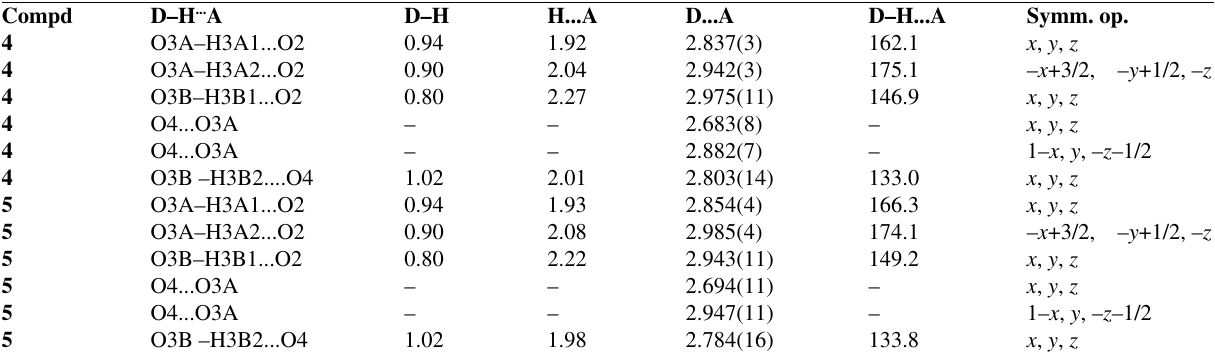
Table 4. Hydrogen bond geometry (Å, °) in trihydrates 4 and 5 .